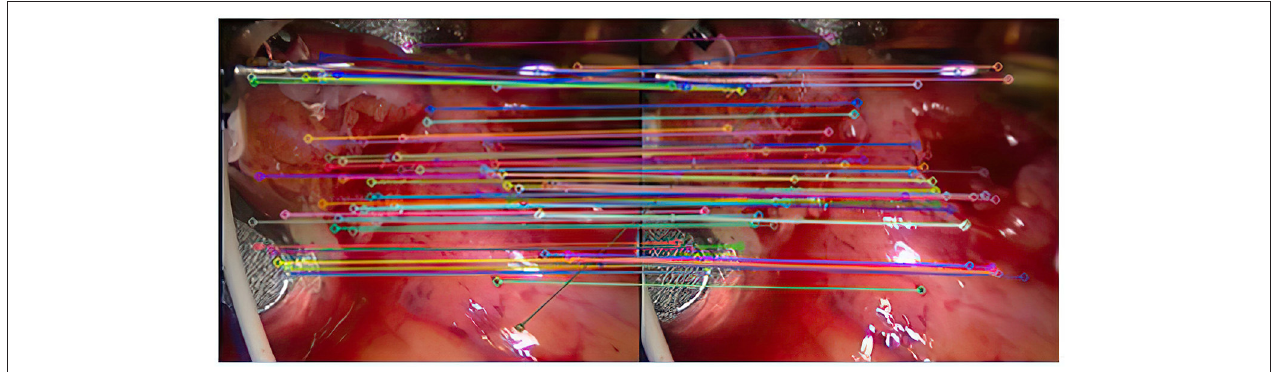
FIGURE 7 | The result of eliminating mismatches by improved purification algorithm.